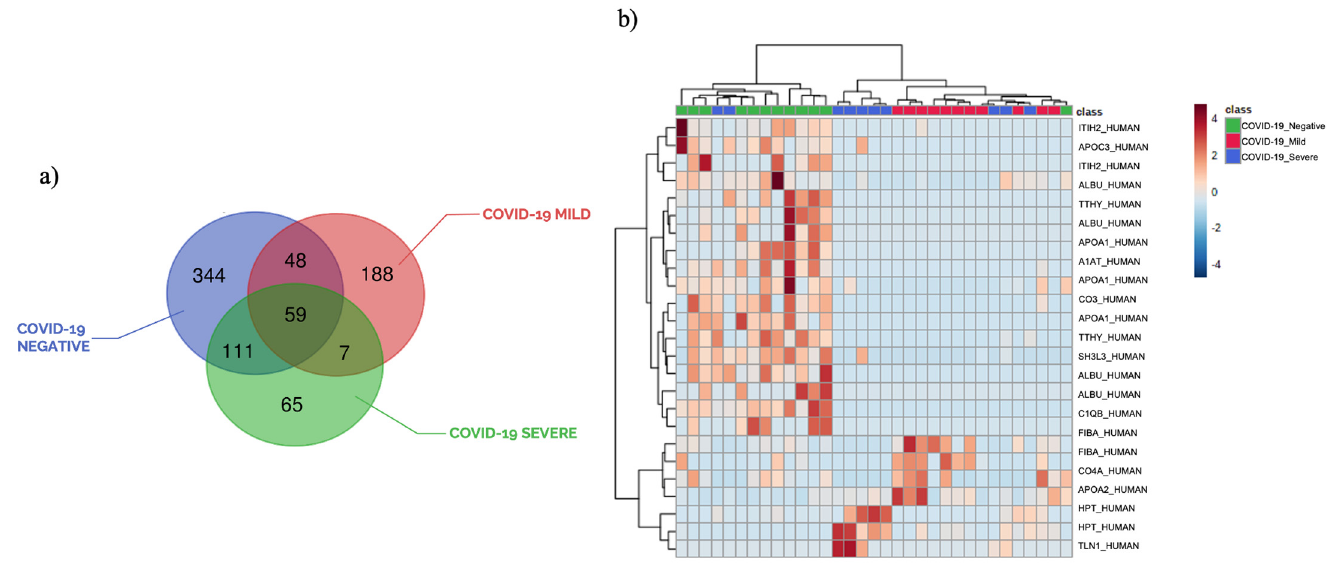
Figure 2. ( a ) Venn Diagram of identified peptides in severe and mildly symptomatic COVID-19 positive patients, and negative controls; ( b ) hierarchical heatmap of identified peptides highlighting the three clusters of samples, with negative controls in green, COVID-19 mild in red, and COVID-19 severe in blue.